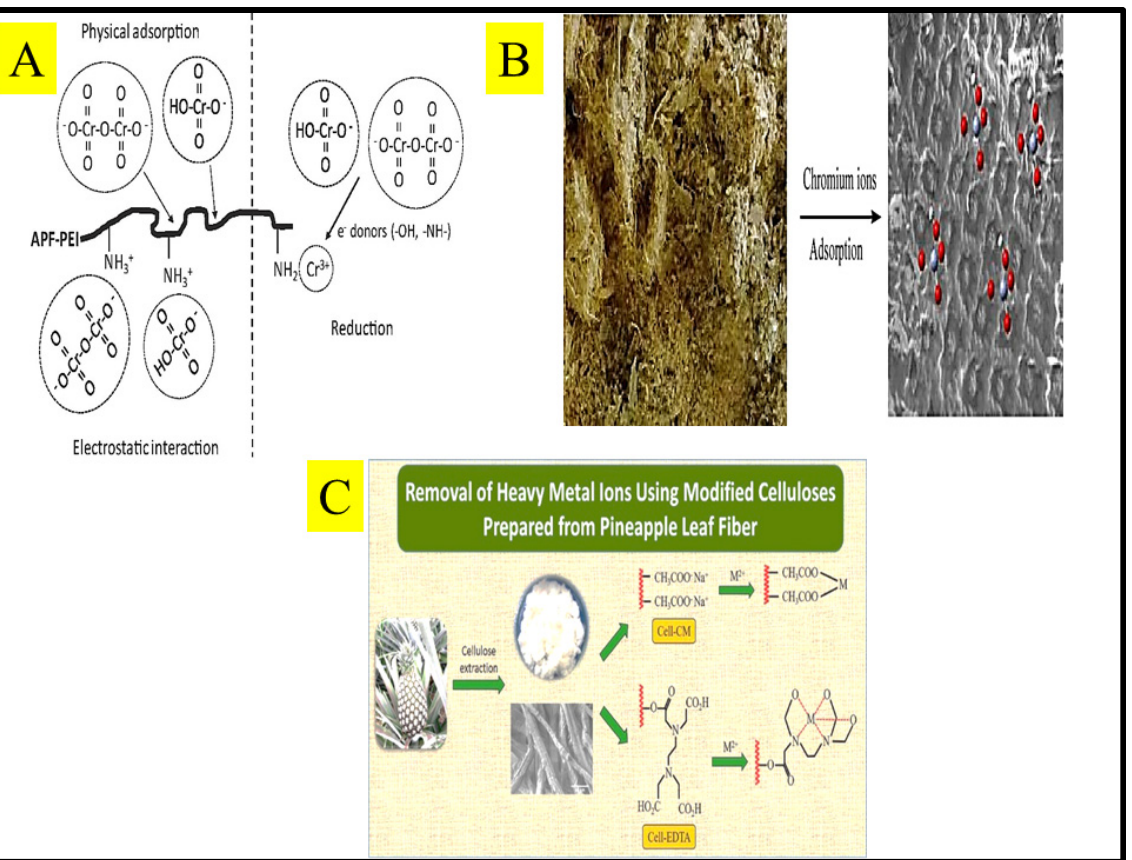
Figure 2. ( A ) the adsorption mechanisms of Cr(VI) on APF-PEI adsorbent; ( B ) Adsorption of Cr(VI) and Cr(III) ions from aqueous solution by PCL; ( C ) the removal of heavy metals using